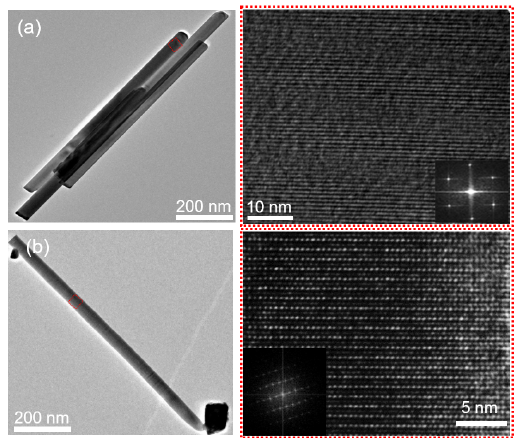
Figure 2. High-resolution TEM image of pure ( a ) zincblende and ( b ) wurtzite InAs nanowires.